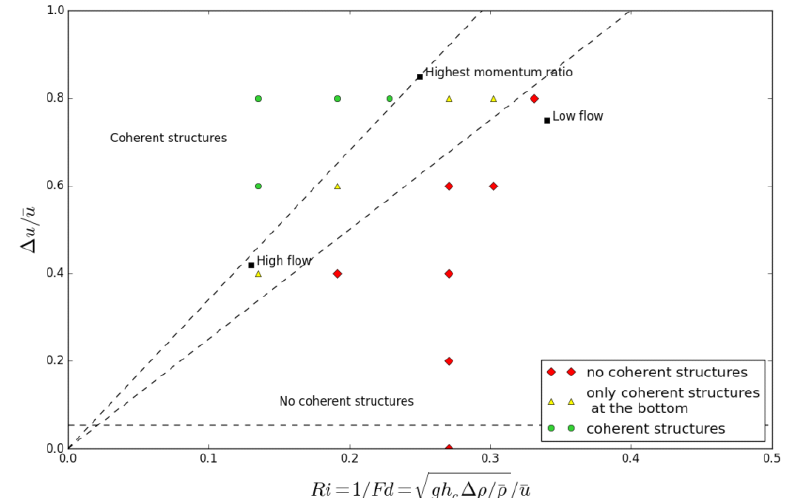
Figure 10. Diagram showing combinations of Richardson number and non-dimensional velocity difference for which coherent structures may or may not develop. Every marker represents one or more model runs, and the shape and color of the marker indicates the occurrence or non-occurrence of coherent structures. The values for the Rio Negro–Solimões model runs (Table 2) are also included. The Richardson number was varied by varying the depth or the density difference; see Table